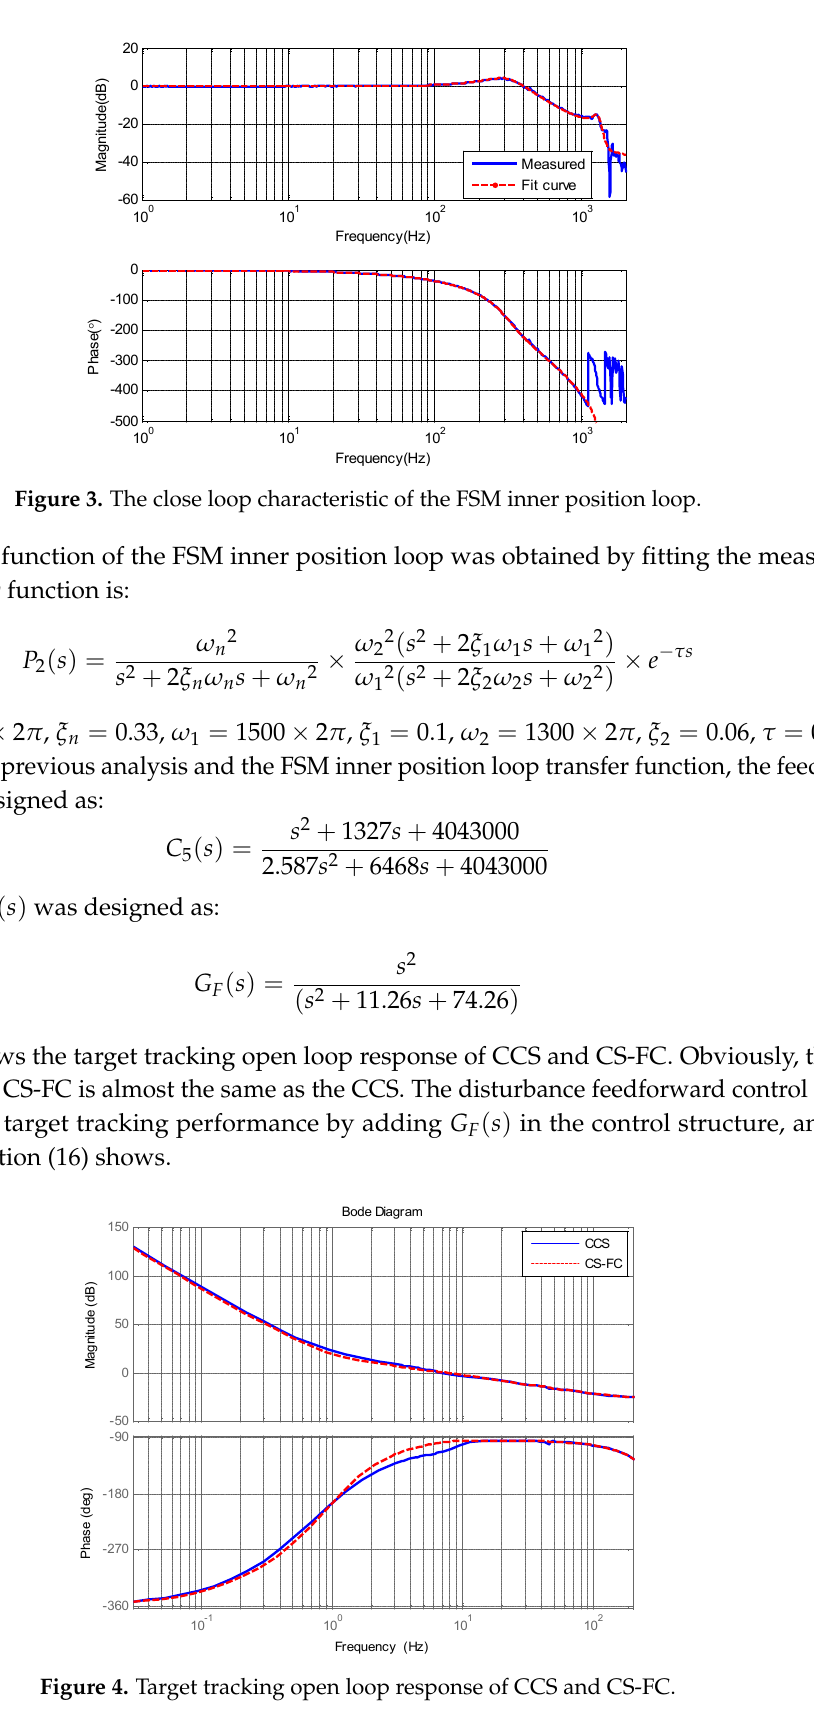
Figure 5. Disturbance rejection performance of classic control structure (CCS) and CS-FC. 4. Experiments and Applications Results Experiments have been done on an EOTS, and the sketch map of the system is shown in Figure 1. The disturbance rejection of CCS and CS-FC in X axis and Y axis can be measured by fine imaging sensor when disturbance platform is moving at a different frequency. Then three experiments in different frequency disturbance are compared in Figures 6–8. Since the gimbal is so heavy, and the disturbance can’t vibrate precisely at too much high frequency, here the max disturbance frequency is given, namely 20 Hz. The stabilization error of CCS and CS-FC and improvement of CS-FC are listed in Table 1. According to experimental results, the CS-FC achieved the best disturbance rejection at 13 Hz, and both the X -axis and Y -axis improved more than 30dB at this frequency compared with the performance of CCS.